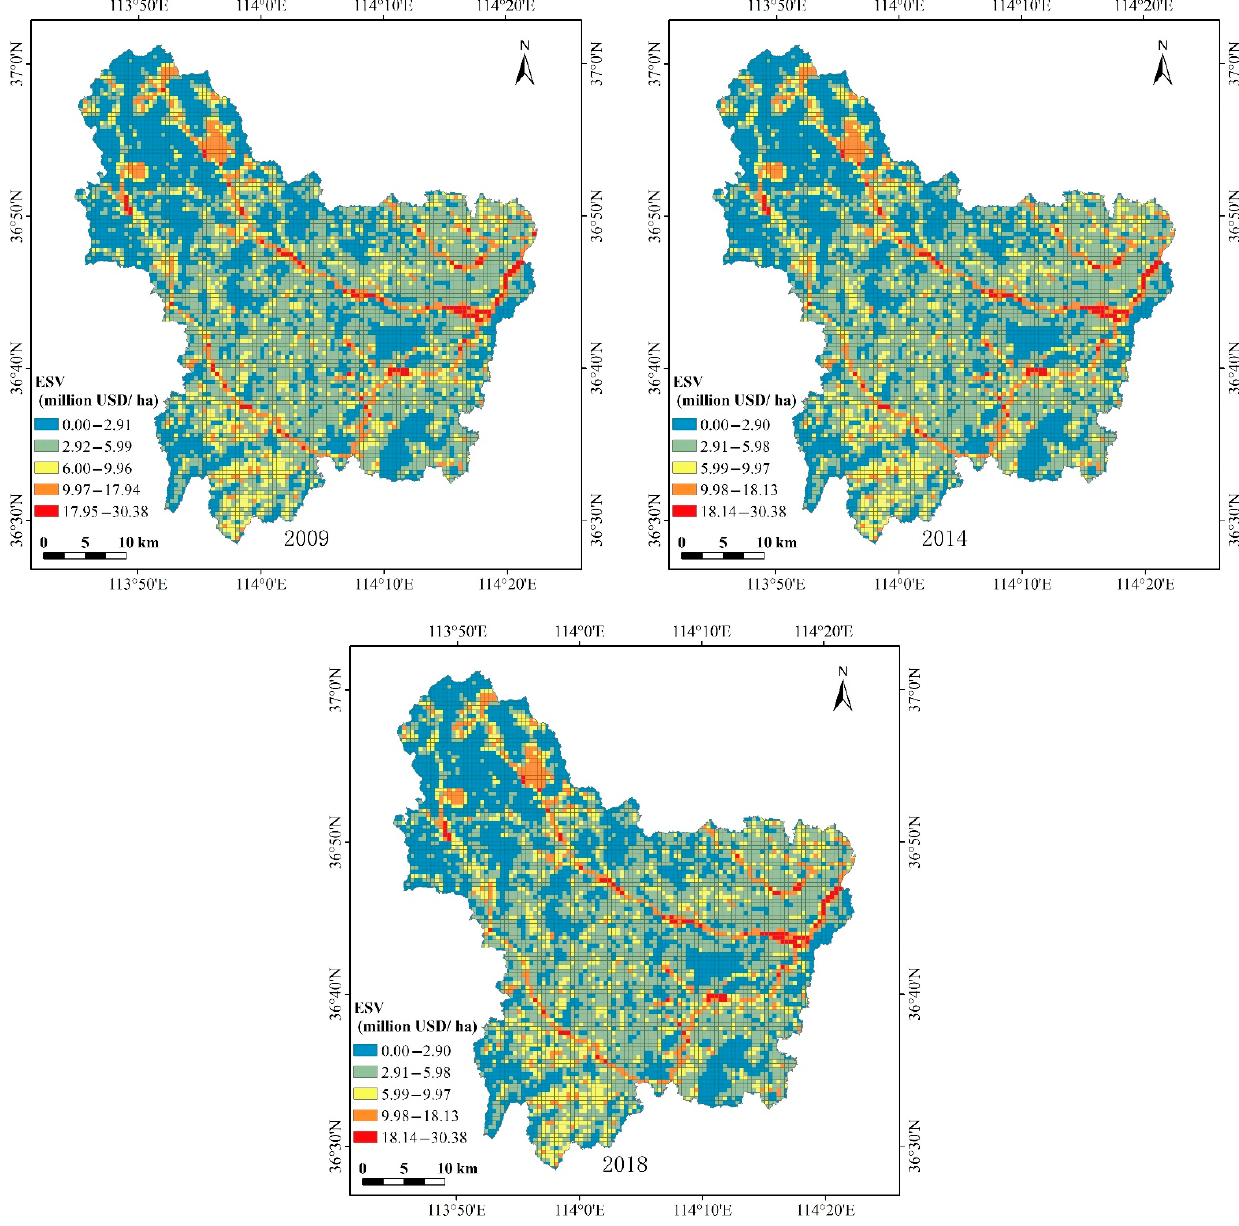
Figure 5. The spatial distribution maps of